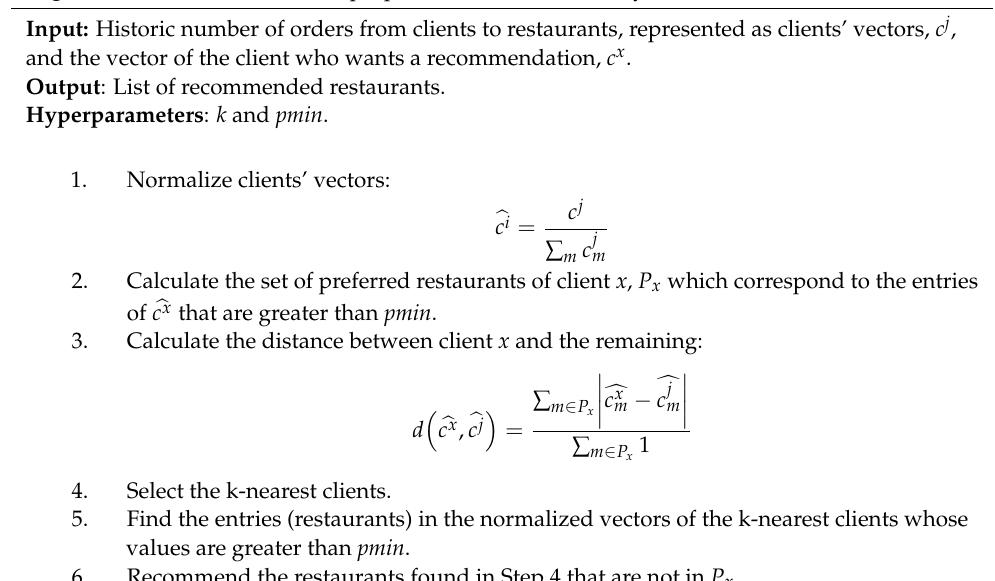
Algorithm 1. Pseudocode of the proposed recommendation system.